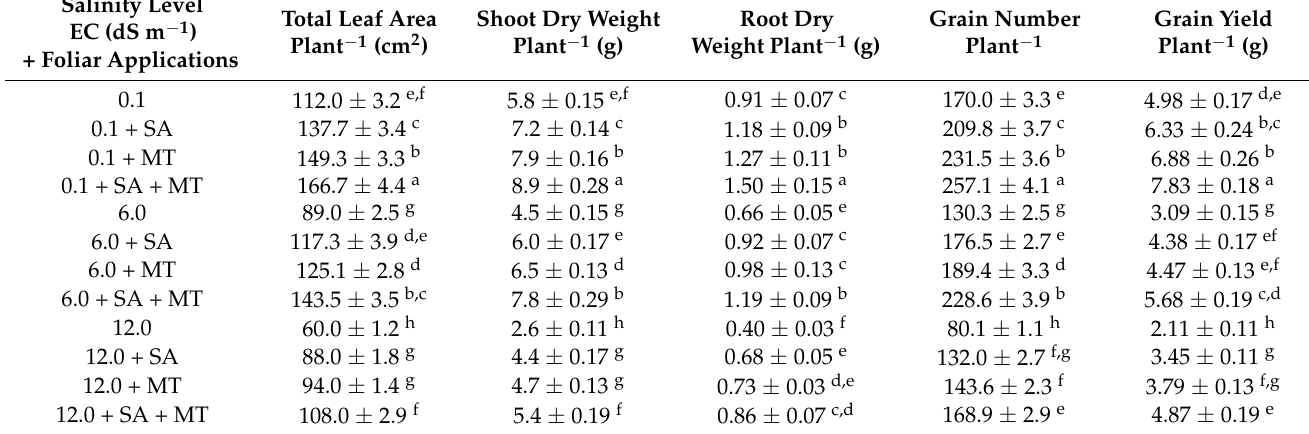
Table 1. Influence of salicylic acid (SA, 75 mg L − 1 ), melatonin (MT, 70 µ M), and SA (75 mg L − 1 ) +